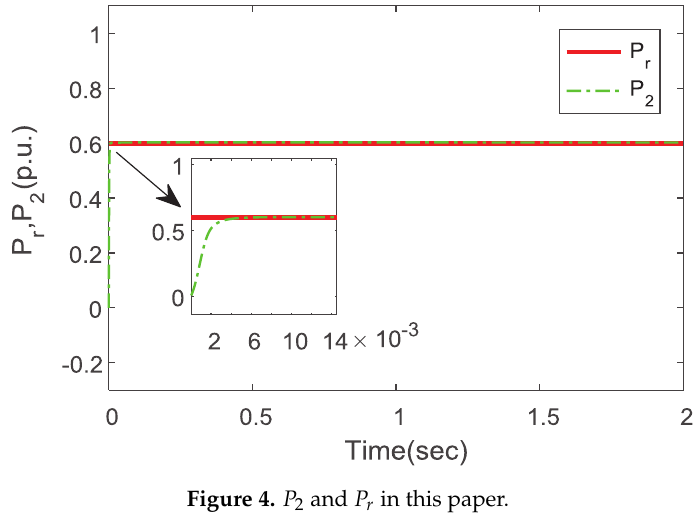
Figure 4. P 2 and P r in this paper.